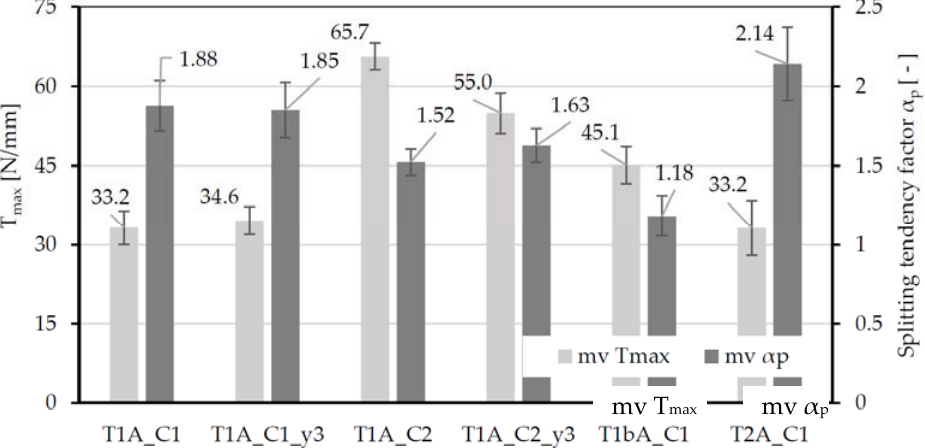
Figure 10. Overview of the reached maximum bond flows (T max ) and the associated splitting-tendency factors for b c = 13 mm, mv = mean value, and standard deviation (sd) given as error indicator.